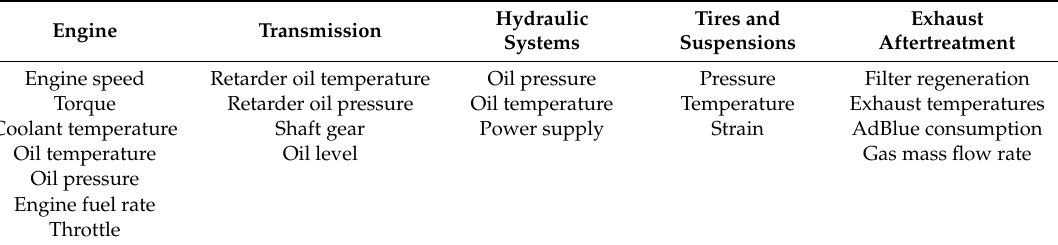
Table 4. Basic technical indicators for